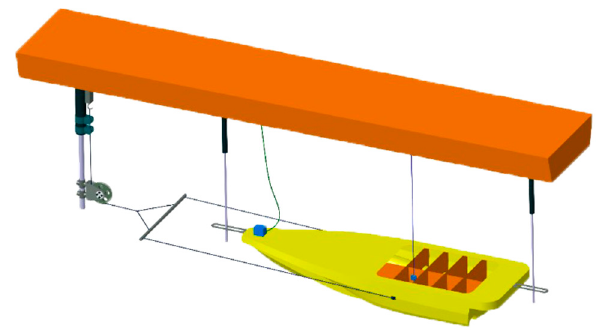
Figure 5. Test plan.